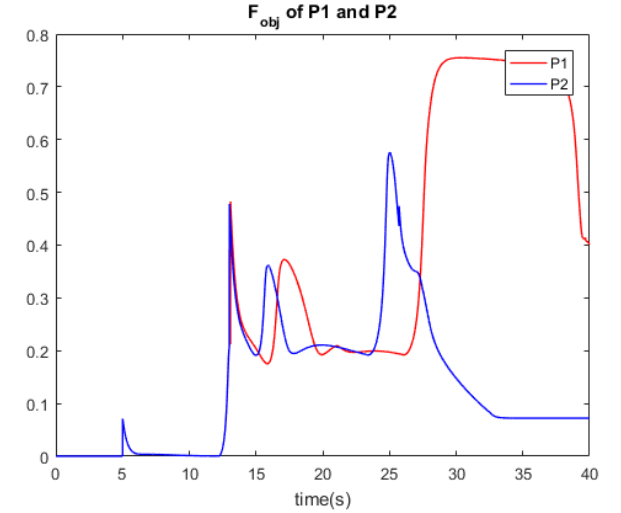
Figure 14. The objective function F obj for robots in formation with P1 and